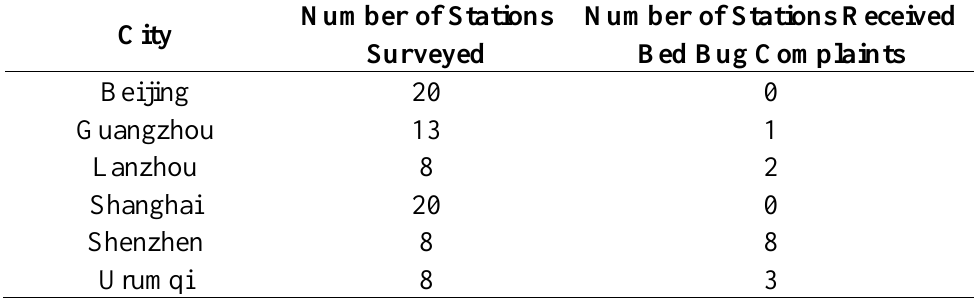
Table 2. Bed bug complaints received by Health and Epidemics Prevention Stations in six Chinese